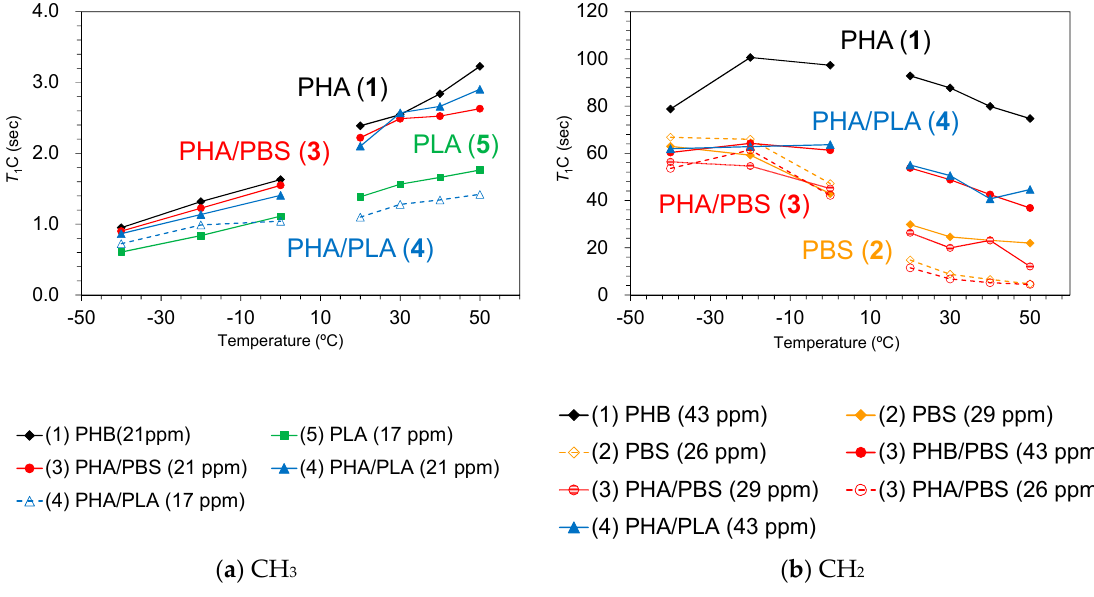
Figure 9. T 1 C changes of CH 3 ( a ) and CH 2 ( b ) groups in plasticized PHA copolymers with rising temperature. The temperature was increased from 40 °C to 0 °C (low-temperature side) and from 20 °C to 50 °C (high-temperature side).